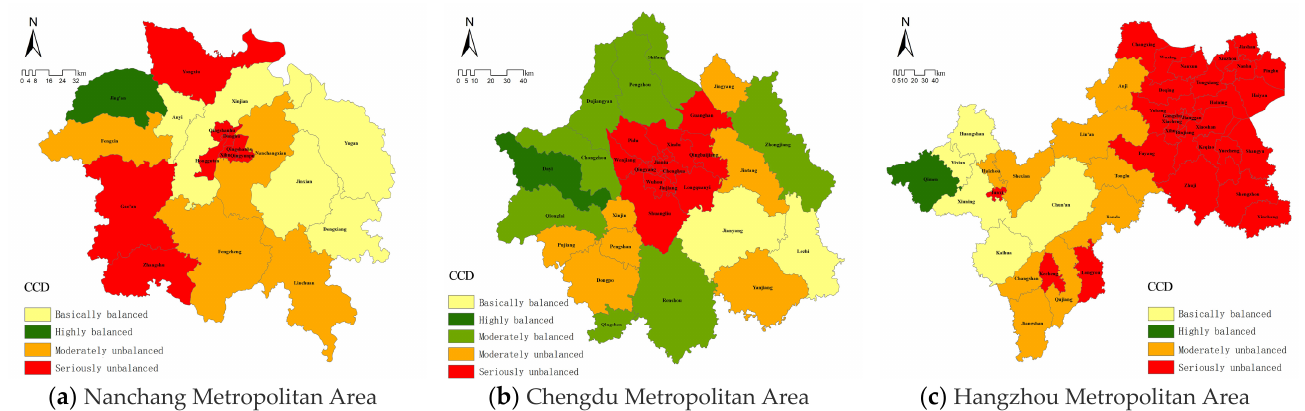
Figure 7. CCD between ECC and ESC in three metropolitan